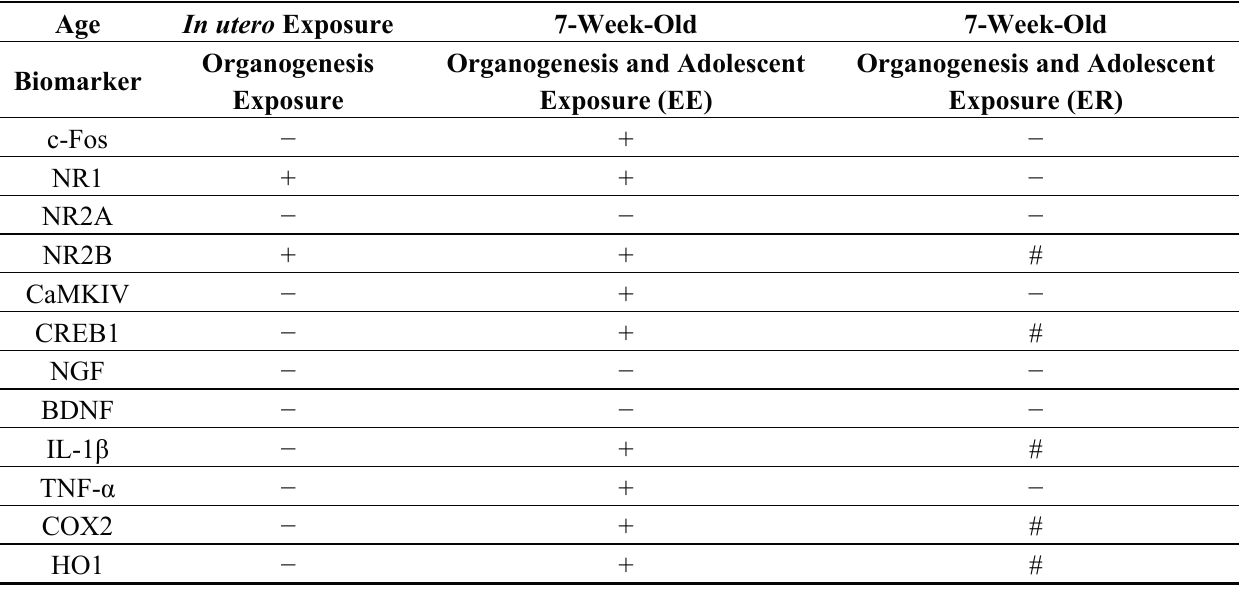
Table 1. Effect of IF-MF exposure during organogenesis period and/or adolescent period on mRNA expression of neurological and immunological biomarkers on in utero exposed male mice and 7-week-old male